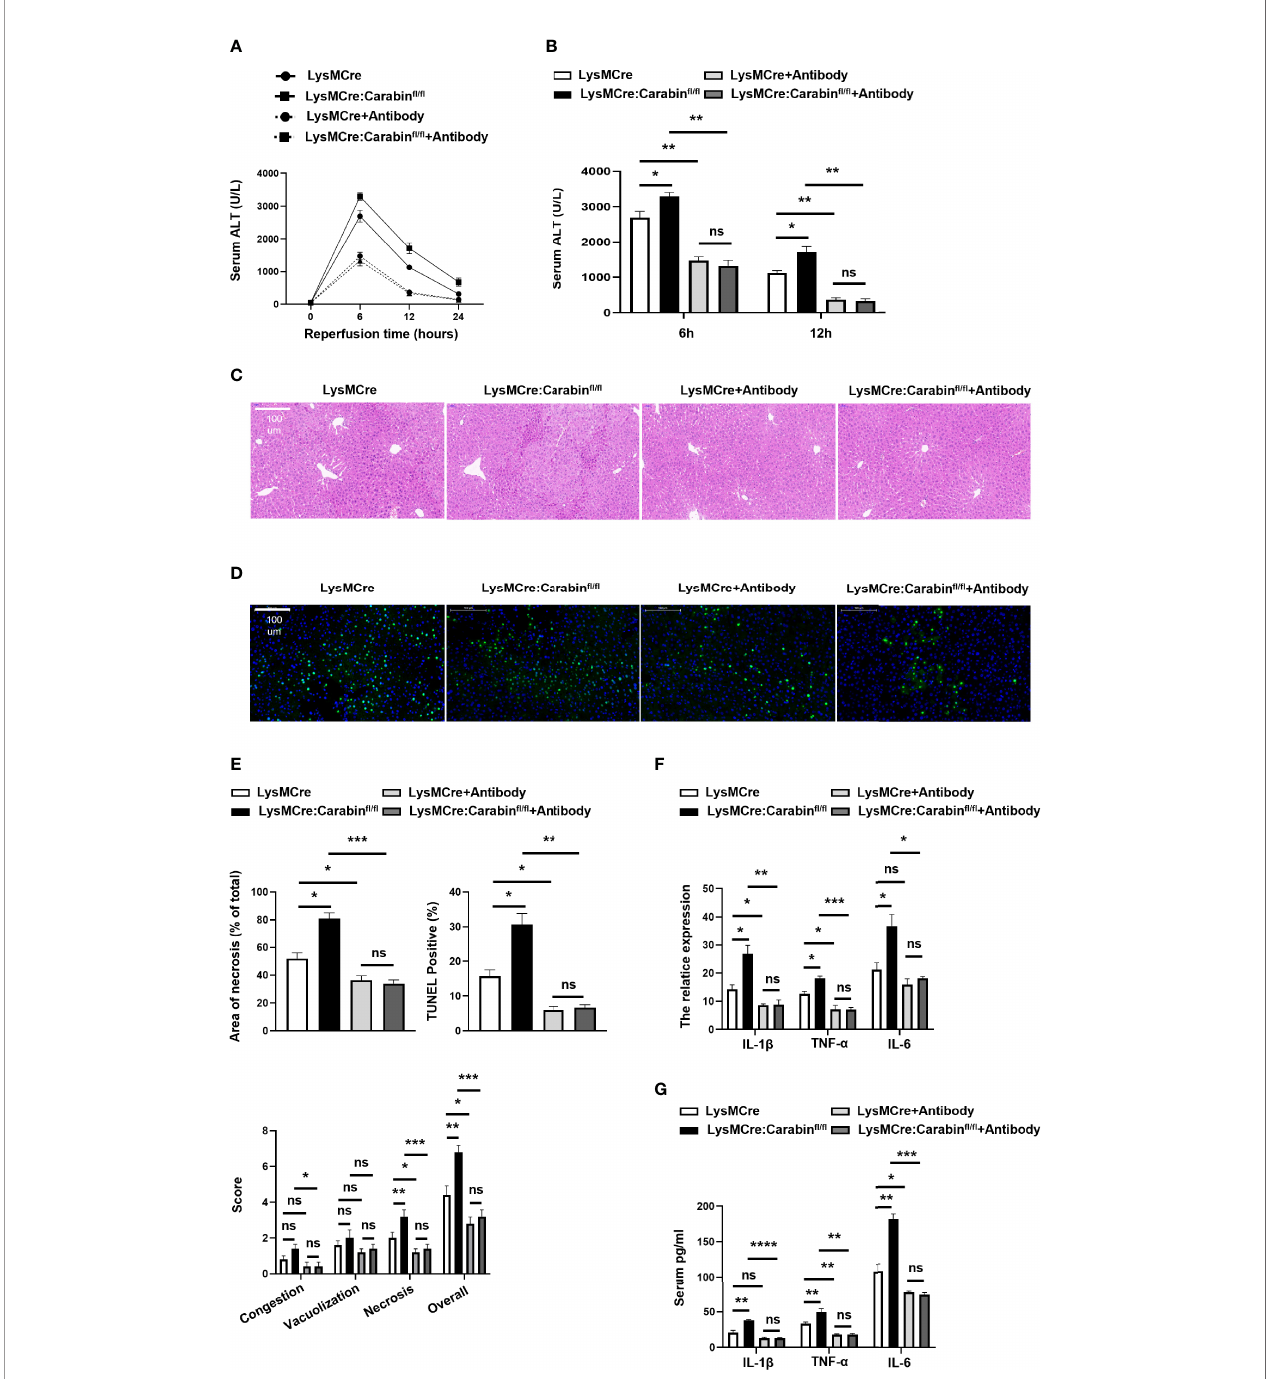
FIGURE 4 | Blocking P-selectin, E-selectin, and a v b 3 integrin alleviates the in fl ammation response pathway. (A) Serum ALT levels in LysMCre and LysMCre : Carabin fl / fl mice with or without P-selectin, E-selectin, and a v b 3 integrin antibody treatments were detected at 0, 6, 12, and 24 h after reperfusion. Data are presented as mean ± SEM (n = 5 mice/group). (B) Analysis of serum ALT levels in LysMCre and LysMCre : Carabin fl / fl mice with or without P-selectin, E-selectin, and a v b 3 integrin antibody treatments subjected to reperfusion for 6 and 12 h. (C) Representative H&E staining images of hepatic samples in LysMCre and LysMCre : Carabin fl / fl mice in the presence of absence of P-selectin, E-selectin, and a v b 3 integrin antibody treatments after HIRI. Scale bar, 100 mm. (D) Hepatic apoptosis of LysMCre and LysMCre : Carabin fl / fl mice treated with or without P-selectin, E-selectin, and a v b 3 integrin antibodies after HIRI was detected by TUNEL assays. Scale bar, 100 µm. (E) Statistical analyses of the area of necrosis and the number of TUNEL-positive cells. Data are presented as mean ± SEM (n= 5 mice/group, 3-5 fi elds were quanti fi ed). (F) The mRNA levels of IL-1 b , TNF- a , and IL-6 were measured by qRT-PCR. Data are presented as mean ± SEM (n = 5 mice/group). (G) Serum IL-1 b , TNF- a , and IL-6 levels were measured by ELISAs. Data are presented as mean ± SEM (n = 5 mice/group). *P < 0.05; **P < 0.01; ***P < 0.001. ns, not signi fi